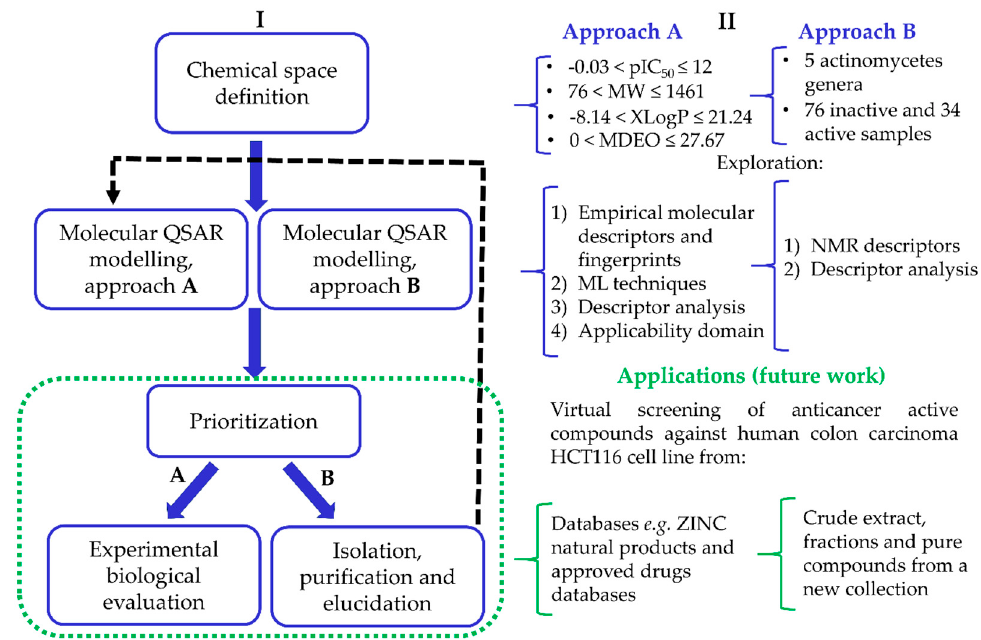
Figure 1. Flowchart representing the HCT116 quantitative structure–activity relationship (QSAR) model building process ( I , left), illustrated with results obtained here as well as future applications ( II , right).